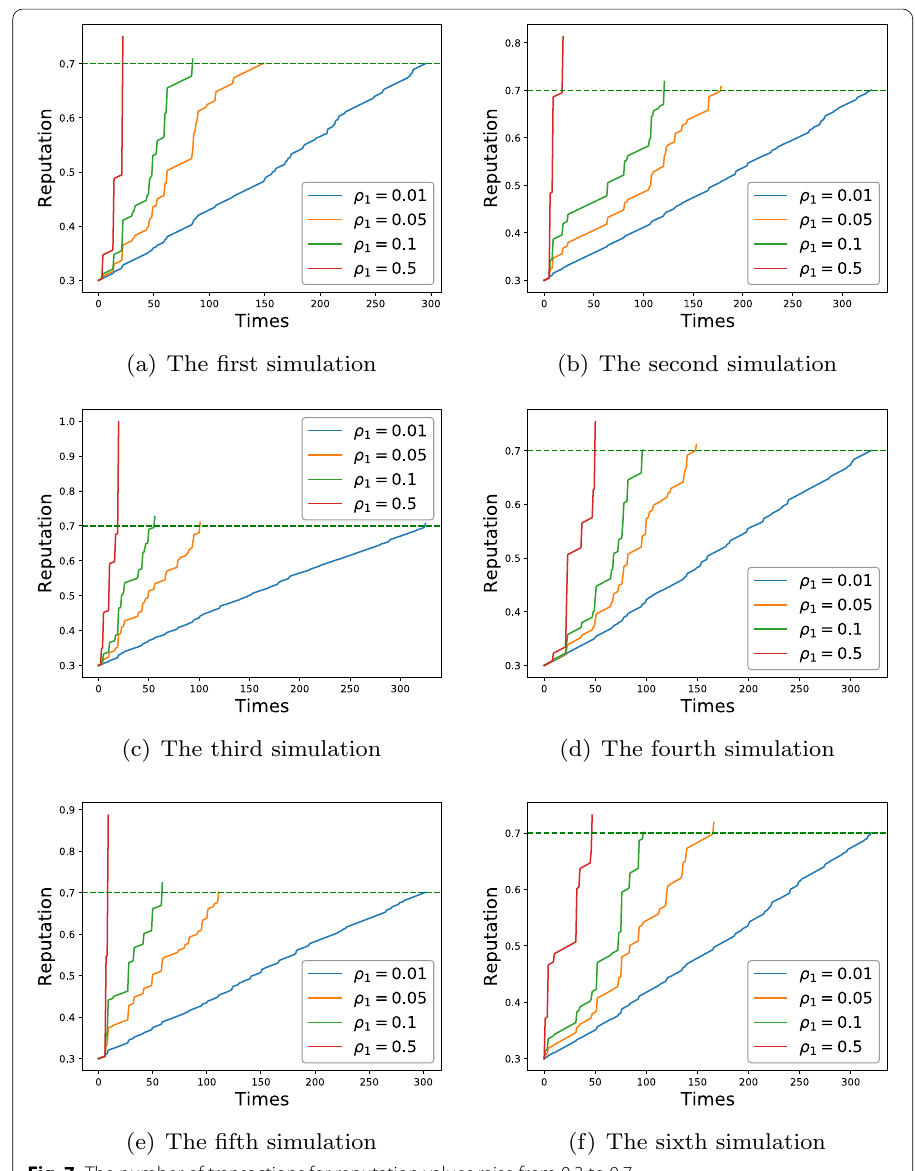
Fig. 7 The number of transactions for reputation values raise from 0.3 to